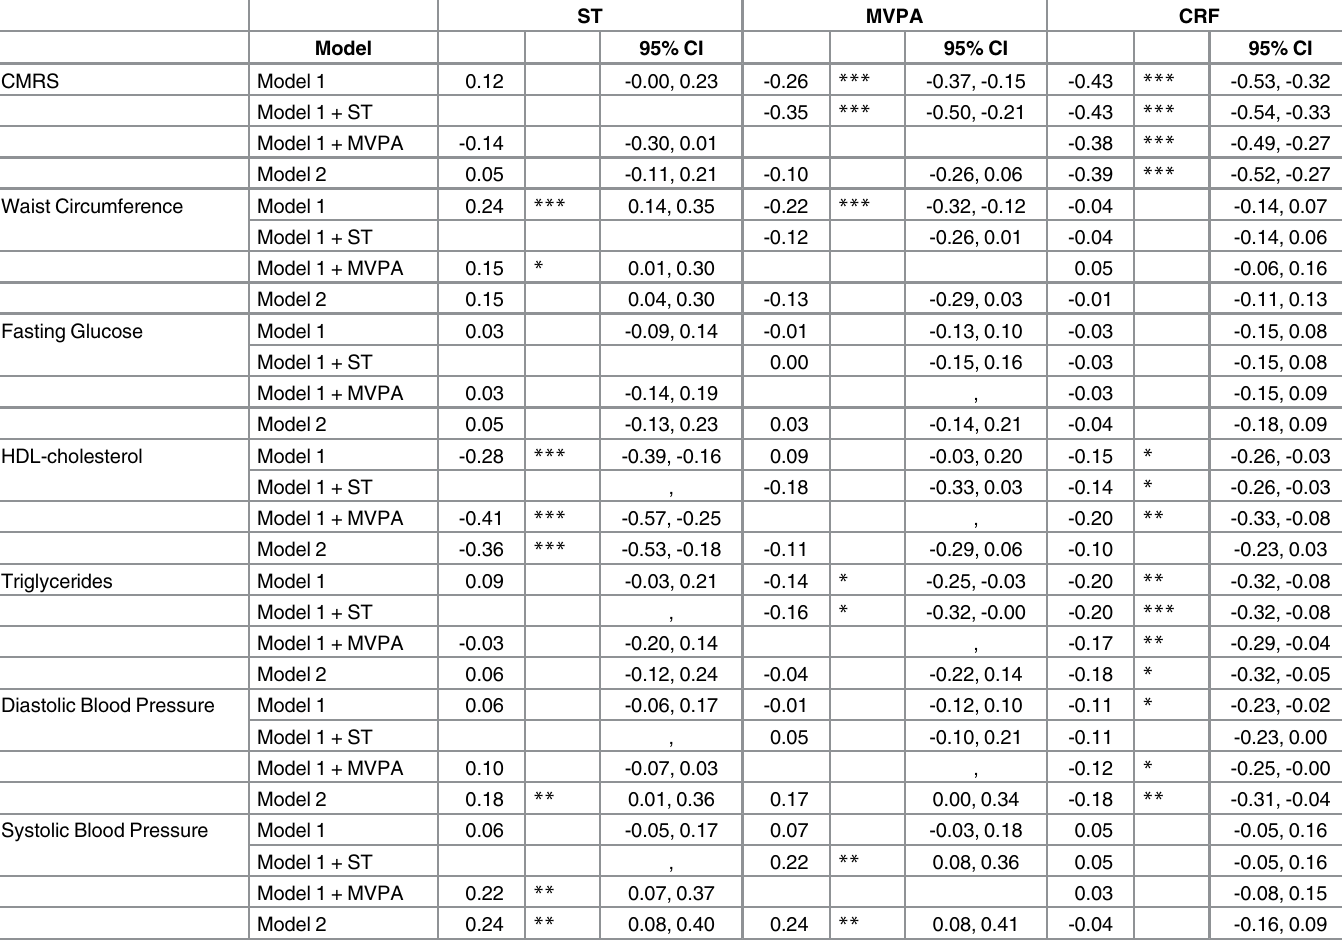
Table 2. Standardized regression coefficients of sedentary behavior, moderate-to-vigorous physical activity and cardiorespiratory fitness for clustered cardio-metabolic health and waist